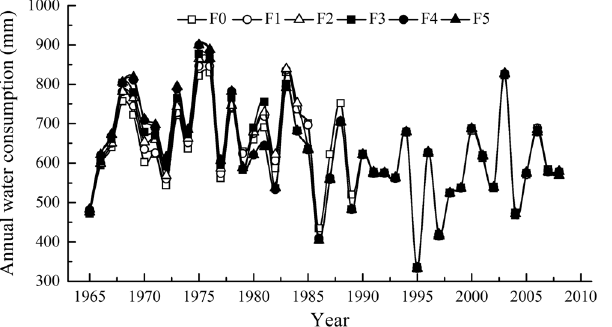
Figure 5. Simulated annual water consumption in the 0–15 m soil layer under different fertilization treatments in the apple orchards of